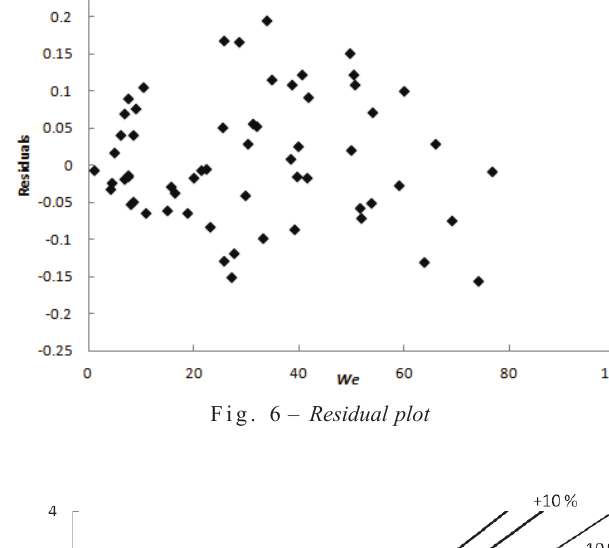
/f ) /(f /f ) )–1 c s ve c s n